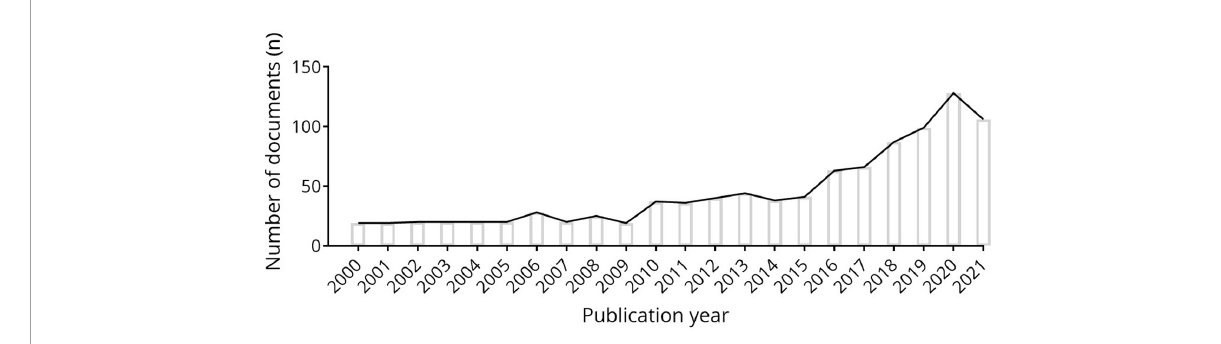
FIGURE1 Annual number of documents indexed in the WOSCC from 2000 to 2021 by the online bibliometric analysis.